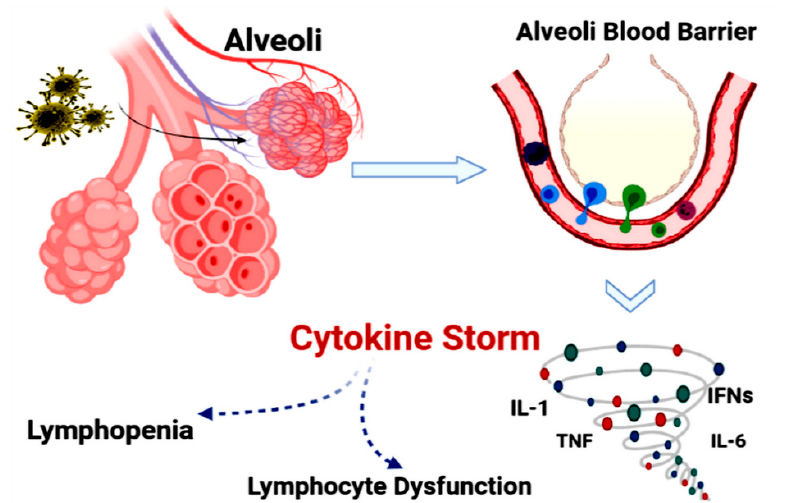
Figure 3. The immunopathogenesis of COVID-19. SARS-CoV-2 disrupts normal immune responses, leading to an impaired immune system and uncontrolled inflammatory responses (e.g., cytokine storm).